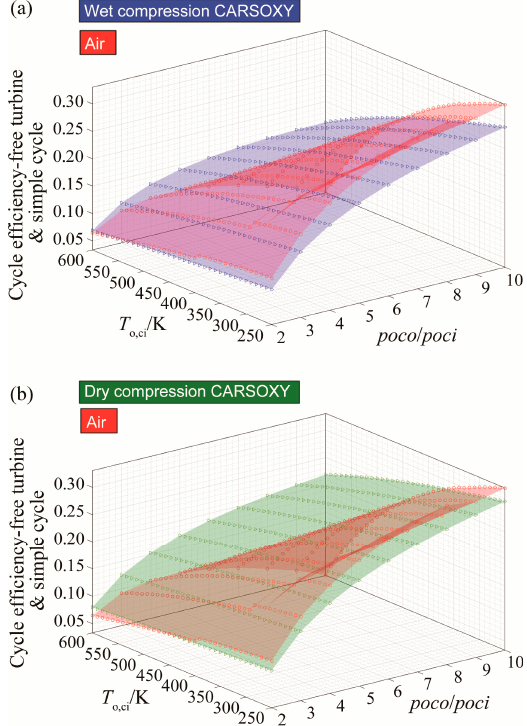
Figure 4. Efficiency results for the free turbine and simple cycle arrangement cycle using ( a ) wet compression and ( b ) dry compression.